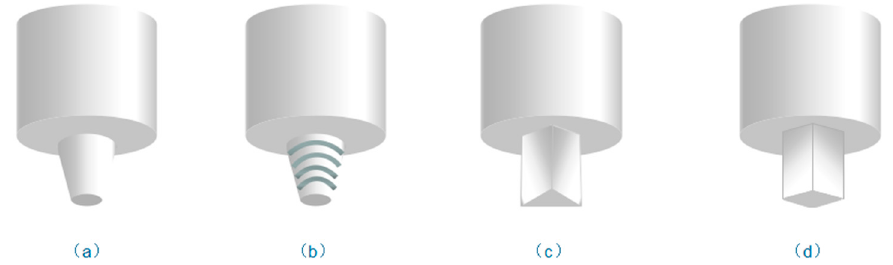
Figure 3. Different shapes of pin: ( a ) circular; ( b ) circular with thread; ( c ) triangular; and ( d ) square.